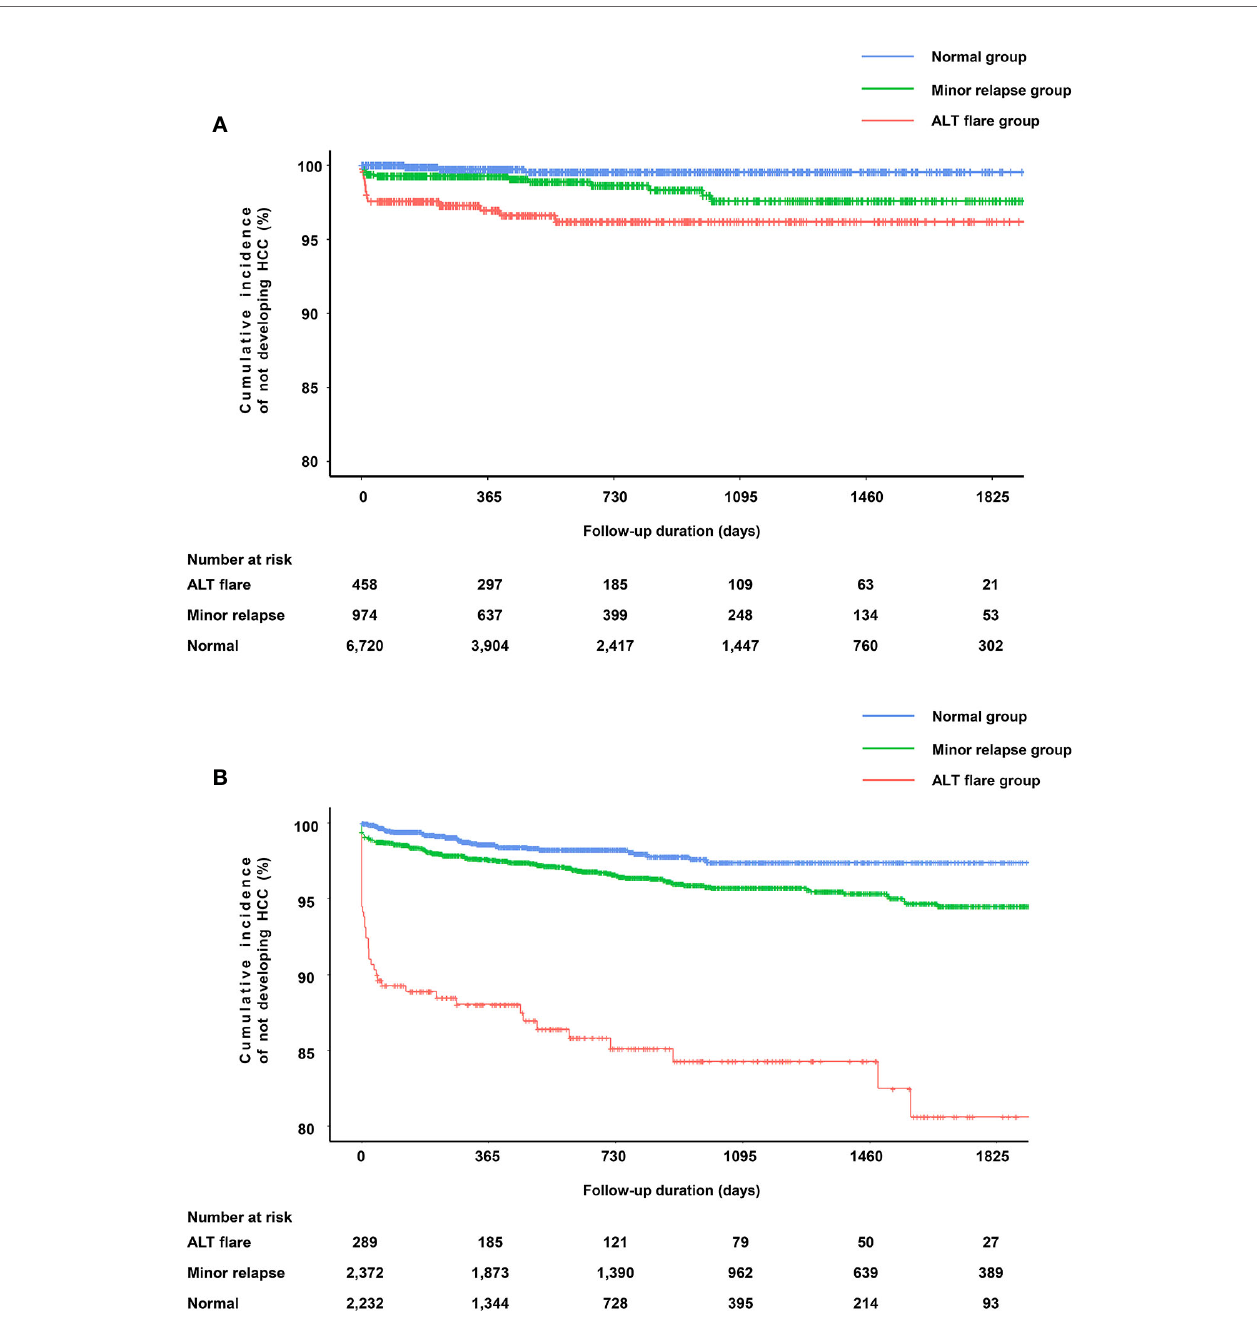
FIGURE 2 | Kapan – Meier curves for HCC according to the ALT pattern. (A) Probability of not developing HCC in the cohort from Ruijin Hospital, China. (B) Probability of not developing HCC in the cohort from Optum EHR database, the